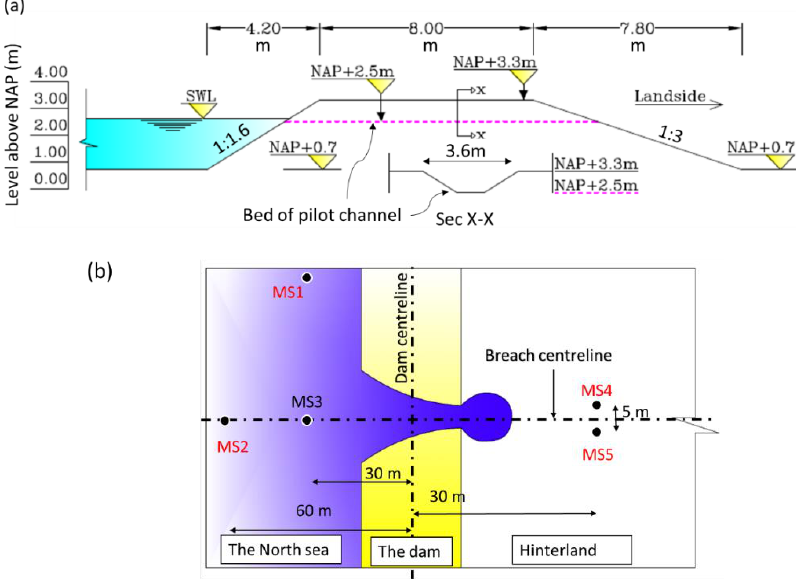
Figure 4. Test case 3: The 1994 dam at Het Zwin: ( a ) dimensions of the dam and the enforced pilot channel (Sec X-X), ( b ) locations of the measuring stations, after Visser (1998 [64]).